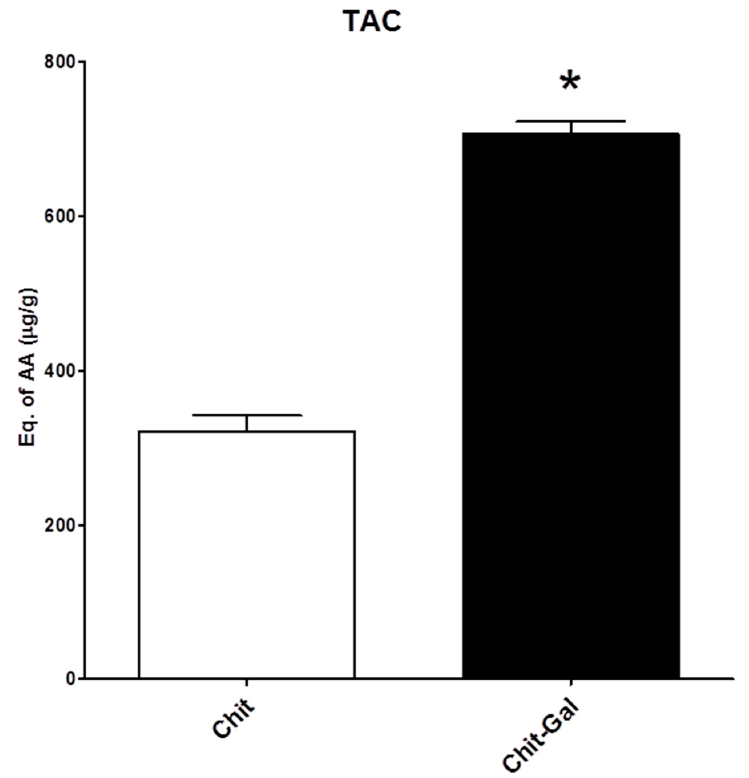
Figure 6. Total antioxidant capacity of the samples, in μ g of ascorbic acid/g sample. *indicates p < 0.05.